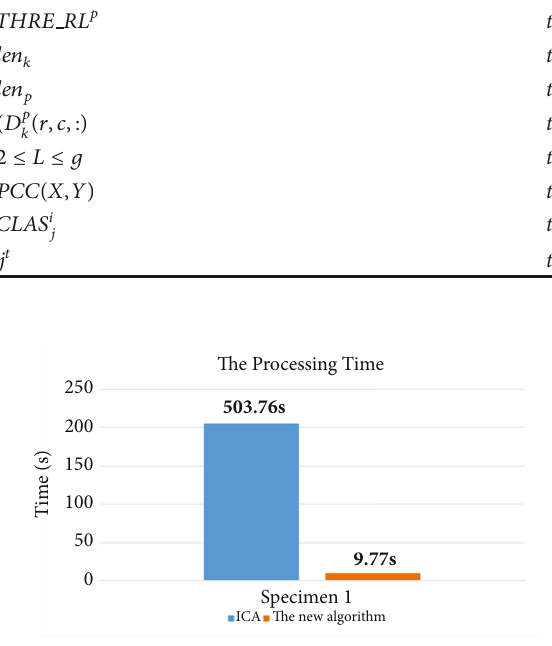
Figure 16: The time comparison for specimen